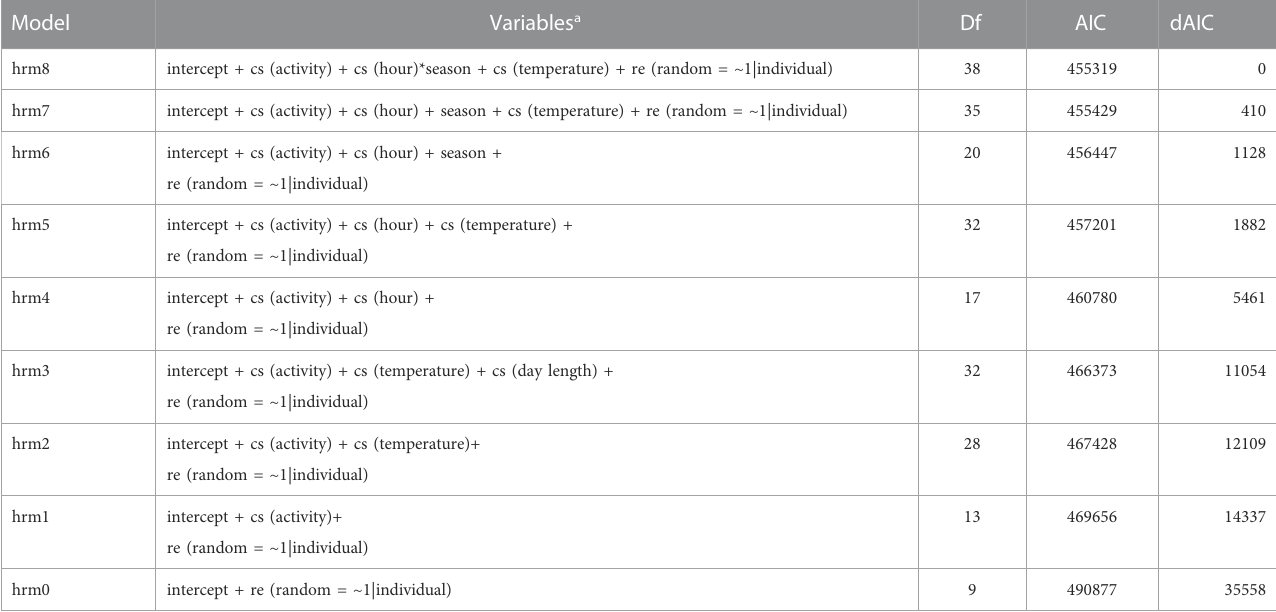
TABLE4TheAkaikeinformationcriterion(AIC)wasusedtodeterminethebest fi tofGeneralizedAdditiveModelsforLocation,Scale,andShape(GAMLSS)forassessing which factors most affect heart rate in six captive scimitar-horned oryx. Lower AIC represent a better performance. Model Variables a